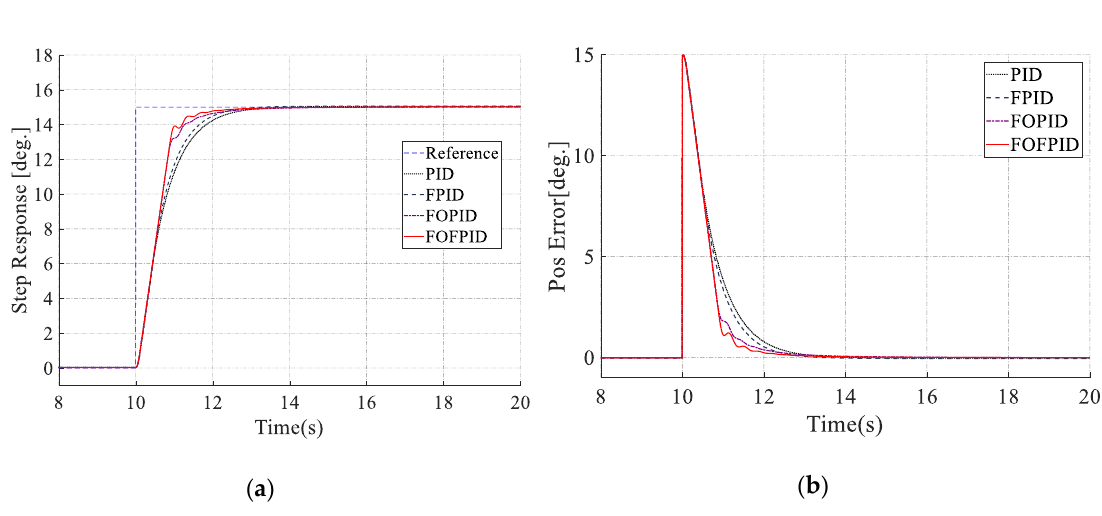
Table 4. Specification parameter of the EHRA system.